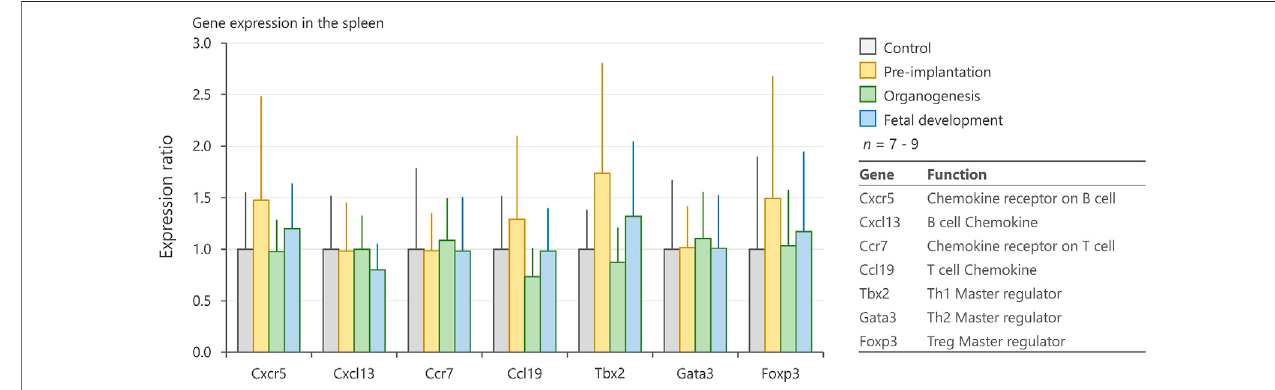
FIGURE 6 | Expression levels of genes related to chemotaxis and differentiation of immune cells in the spleen. mRNA expression levels of Cxcr5 , Cxcl13 , Ccr7 , Ccl19 , Tbx2 , Gata3 , and Foxp3 in the spleen on postnatal days 1, 3, and 5, as measured by qRT-PCR. Values are expressed as the mean ± SD.